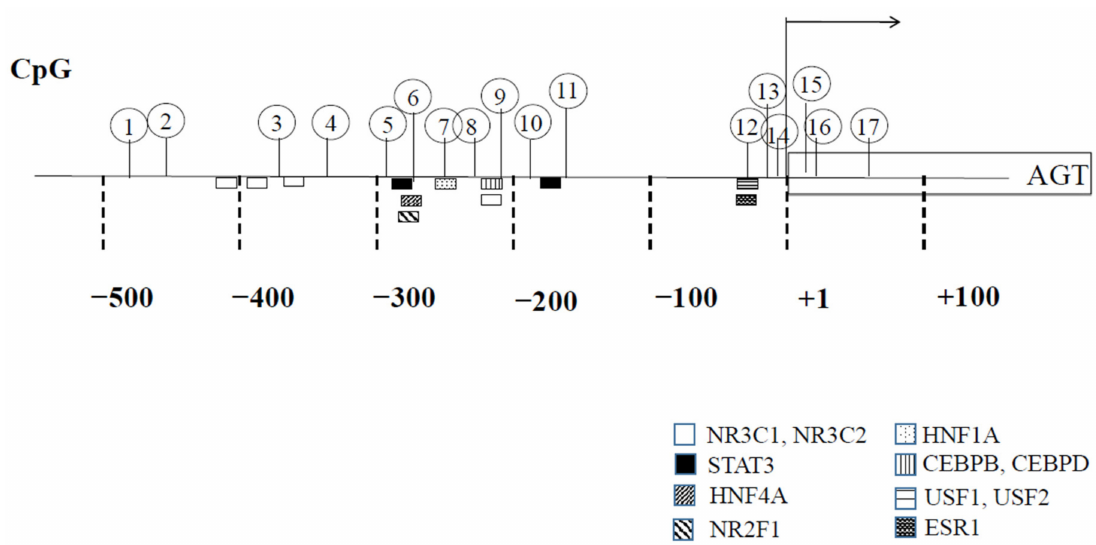
Figure 2. CpG dinucleotides and transcription factor-binding sites in the AGT promoter. Nucleotide numbers are relative to the transcription start site. CpG dinucleotides from − 483 to + 78 are numbered from the 5 (cid:48) to 3 (cid:48)